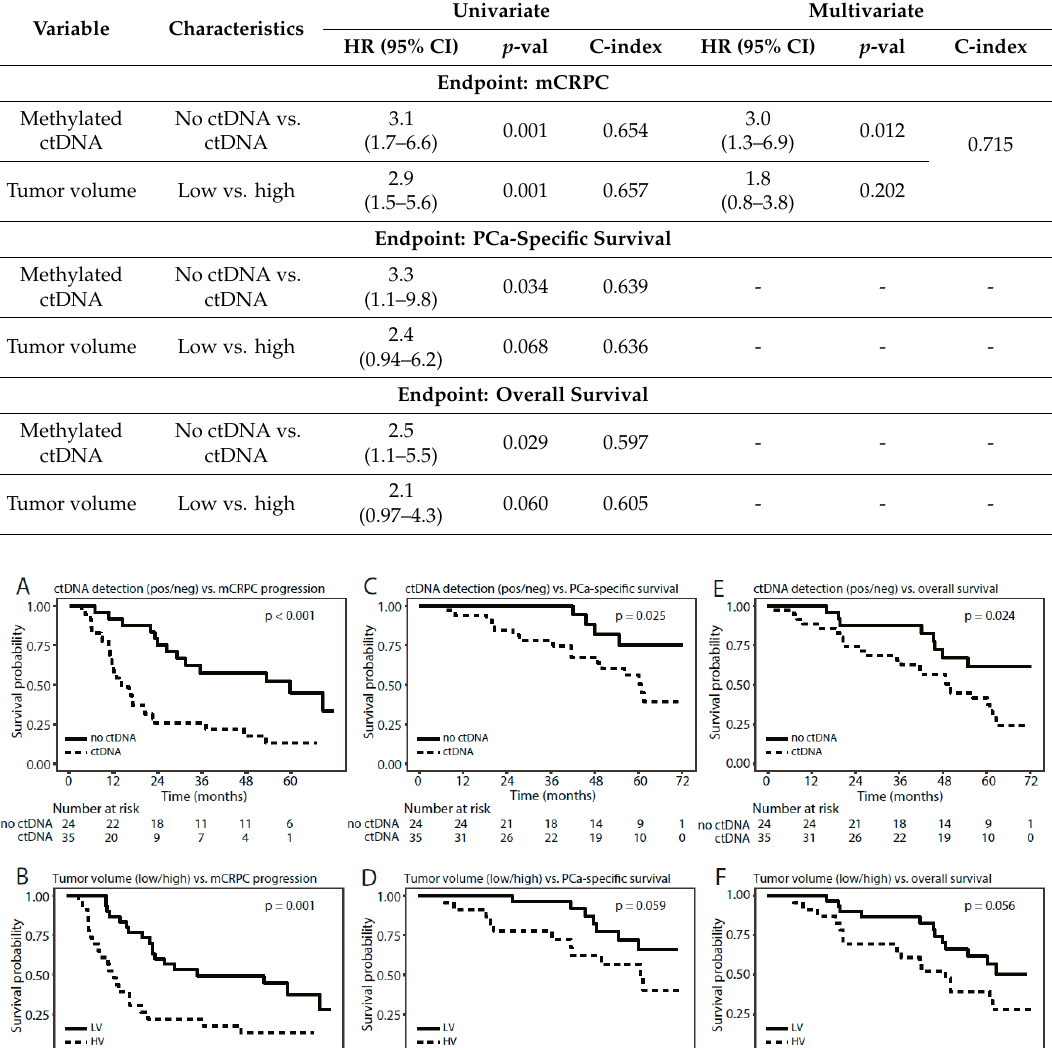
Table 2. Univariate and multivariate Cox regression using time to metastatic castration-resistant PCa (mCRPC) progression, PCa-specific, and overall survival as endpoints. Detection of methylated ctDNA was defined as detection by at least one assay.